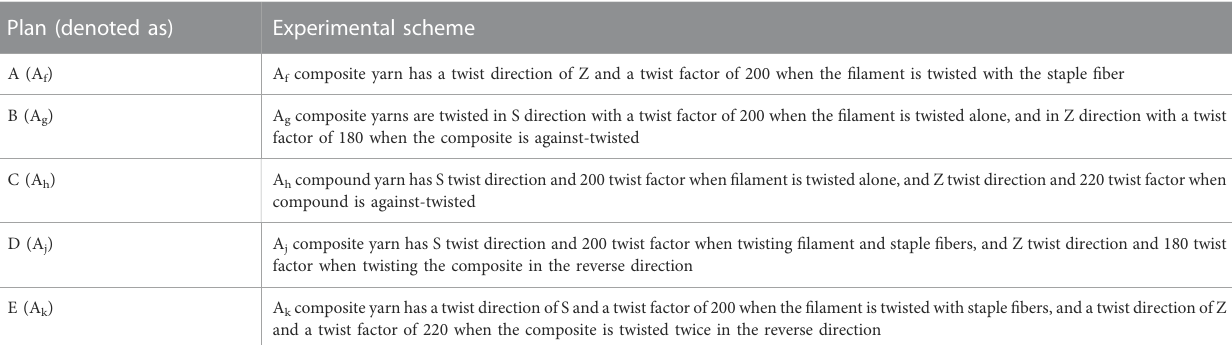
TABLE 1 Experiment design of composite